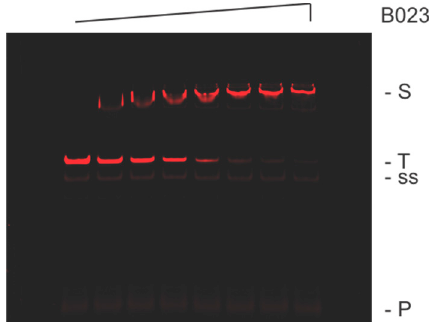
Figure 3. EMSA analysis of TTHB023-binding to its consensus sequence. Shown are IR fluorescence images of TTHB023 palindromic DNA incubated with 0, 13, 26, 52, 104, 208, 415, or 830 nM TTHB023 protein. (S) Protein–DNA complex, (T) uncomplexed DNA, (ss) single-stranded DNA, and (P) IRD7_ST2R primer.